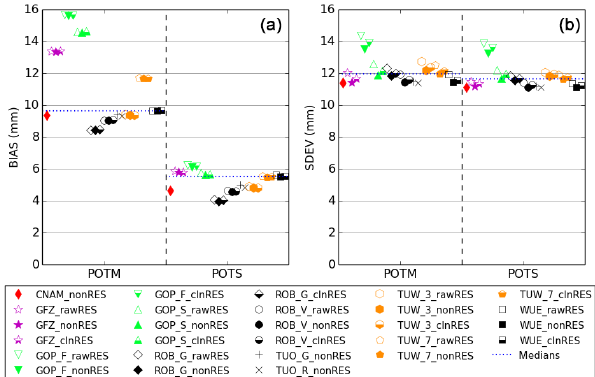
Figure 10. Comparison of individual GNSS STD solutions for sta- tions POTM and POTS versus WVR measurements, expressed in the zenith direction, bias (a) and standard deviation (b) . The median value of all solutions at each station is represented by the dotted blue line in each